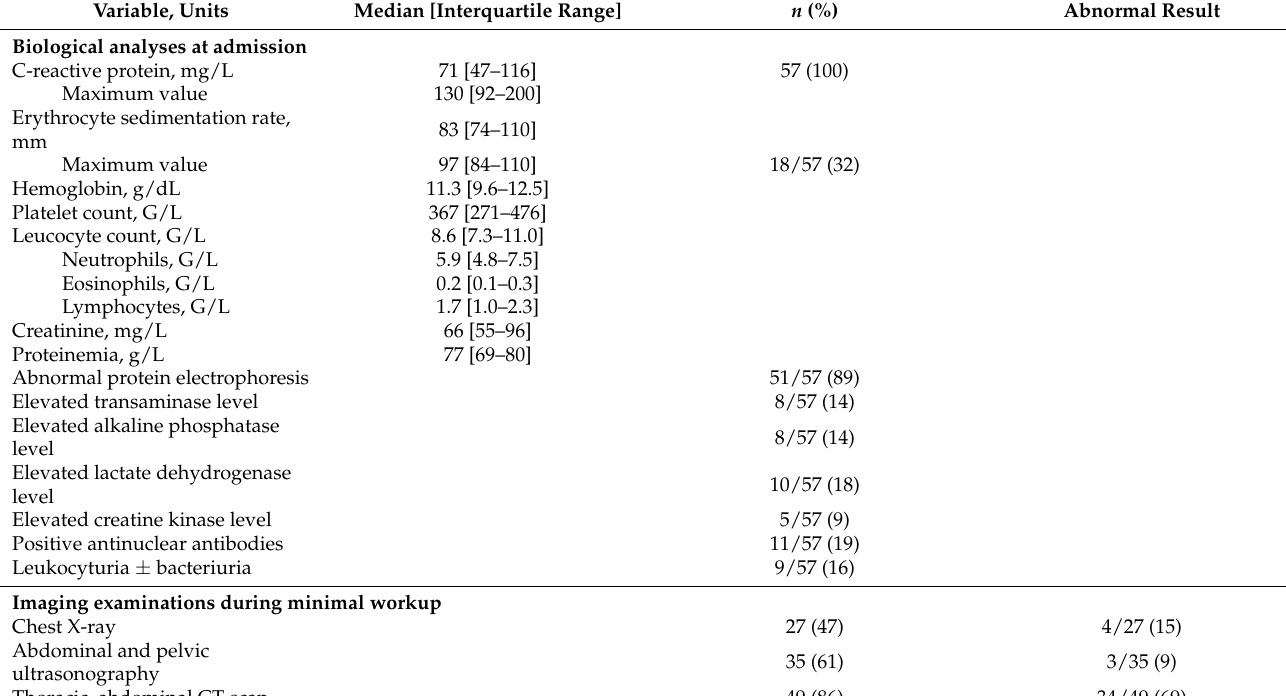
Table 2. Initial diagnostic